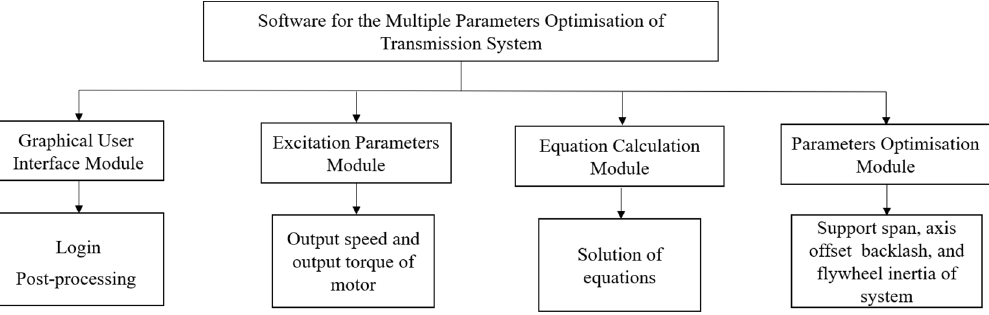
Figure 8. Structure diagram of parameter optimization software for transmission system.